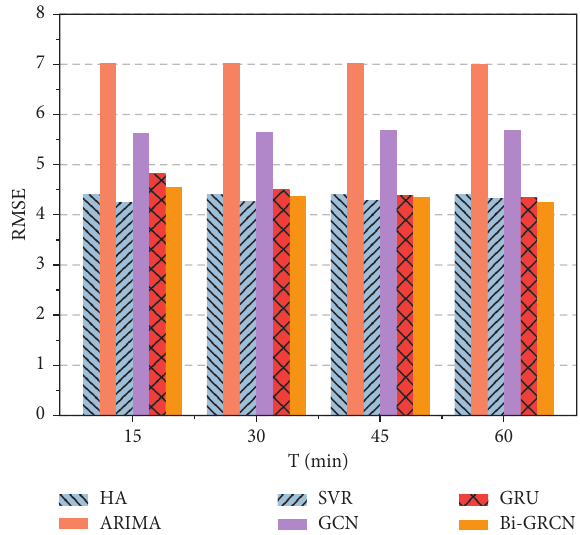
Figure 11: RMSE of various models.